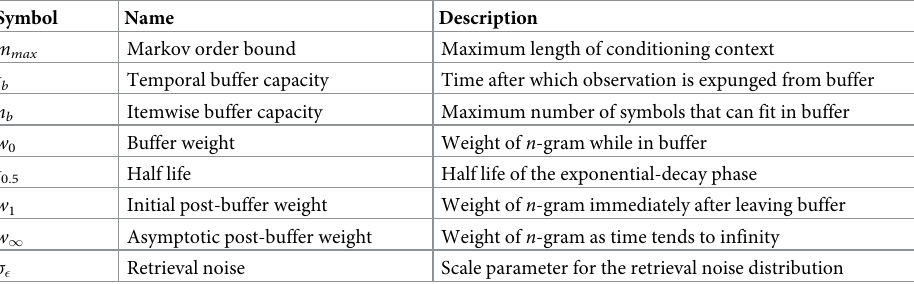
Table 3. Summary of PPM-Decay